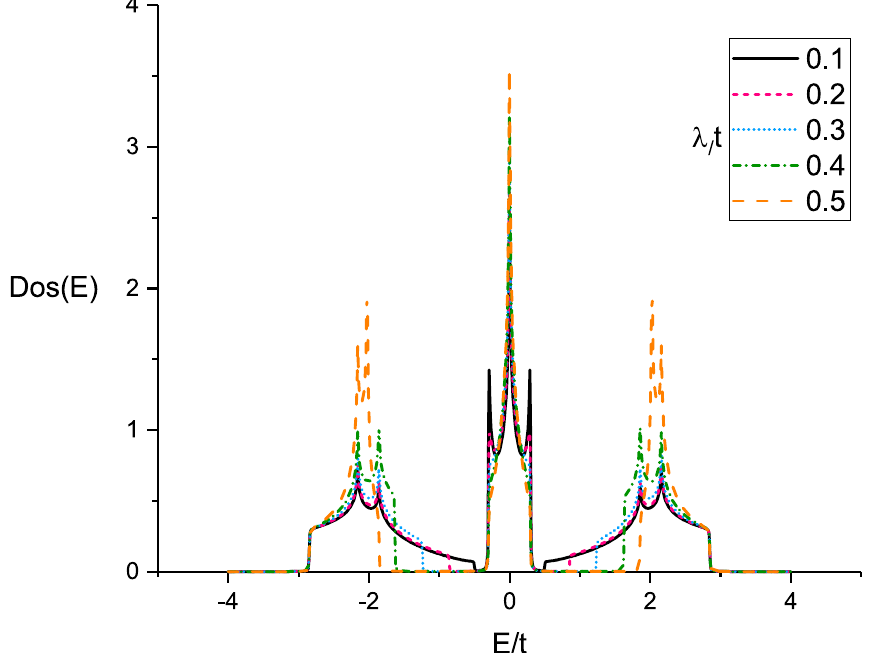
Figure 3. Density of states (DOS(E)) of electrons on Lieb lattice as a function of energy for different values of normalized spin-orbit coupling strength (cid:31) / t in the absence of magnetic field at fixed gap parameter �/ t = 0.3 .